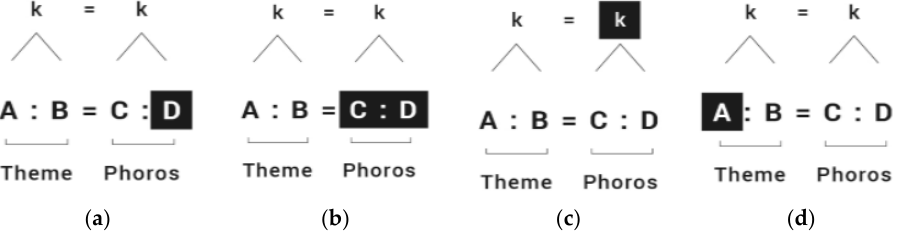
Figure 4. Schemes of all the manipulations allowed by the model: ( a ) Replacing one term of the phoros . This will automatically change the k-interpretant ; ( b ) Replacing the whole phoros pairs. As in the previous case, the k-interpretant will consequently mutate; ( c ) Replacing the k-interpretant of the phoros ; ( d ) Replacing—or discovering—an unknown term of the theme which, however, is needed to ignite the analogy